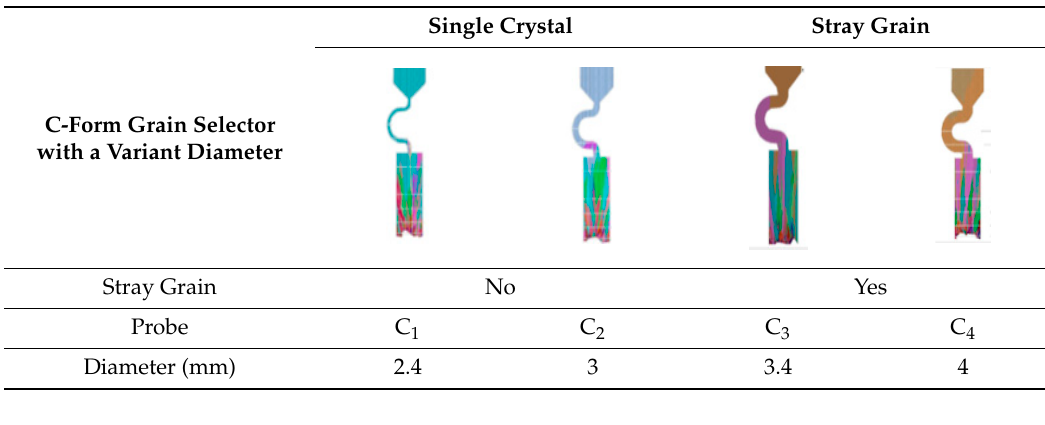
Table 2. Variation in thickness of the grain selector portion.